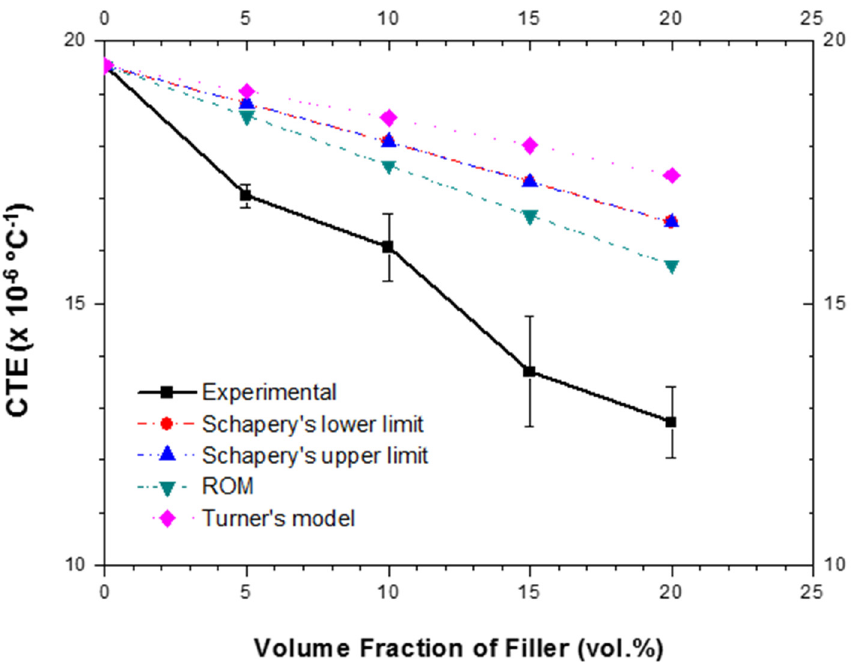
Figure 7. Experimental CTEs (between 25 and 400 °C) of MMC (Alumix-231/fused silica) sintered at 565 °C and CTEs predicted by different micromechanical models.